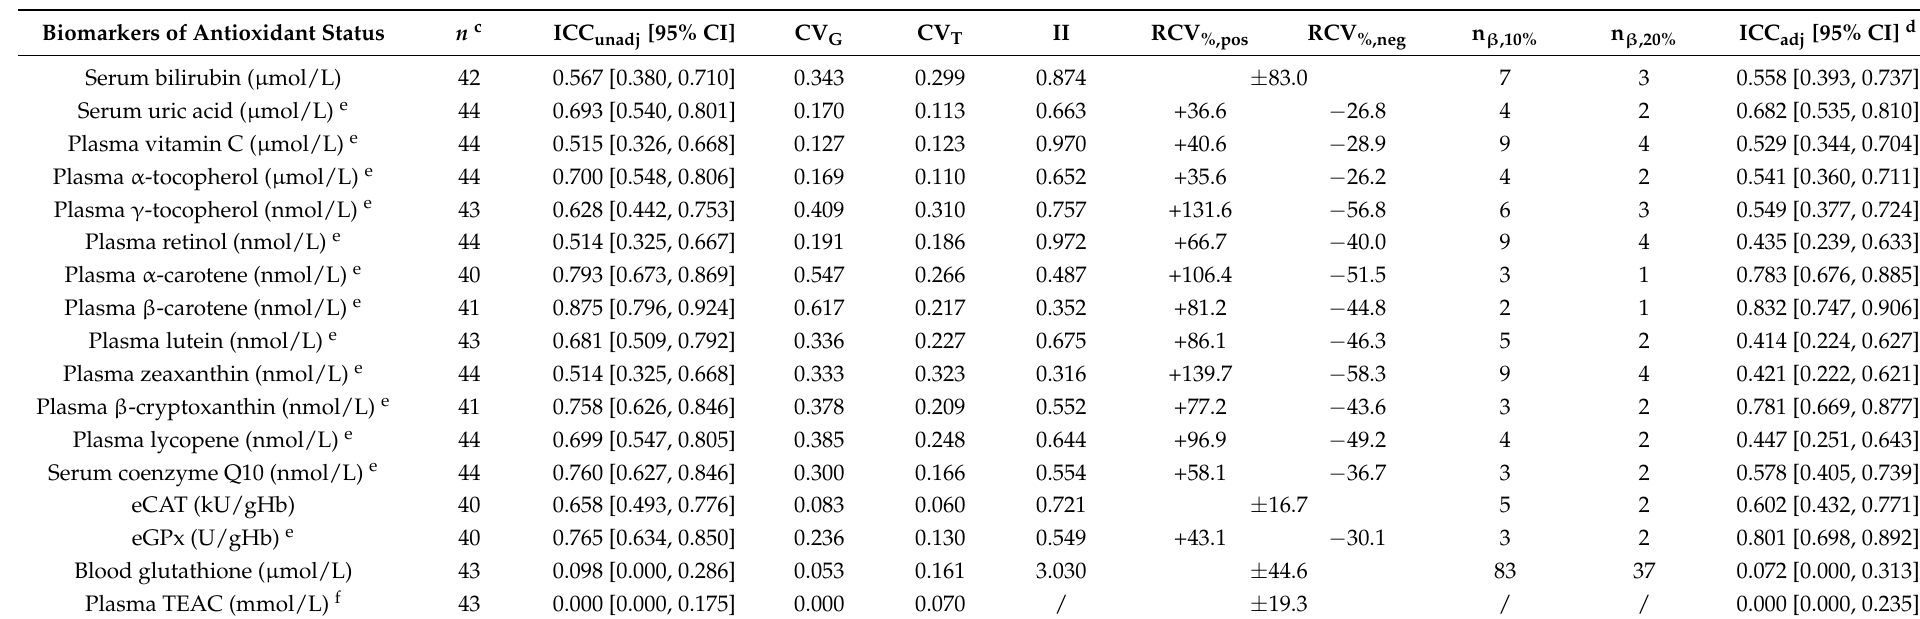
Table 2. Crude and adjusted indicators of reliability and inter- and intra-individual variability for each antioxidant biomarker in premenopausal women a,b . Biomarkers of Antioxidant